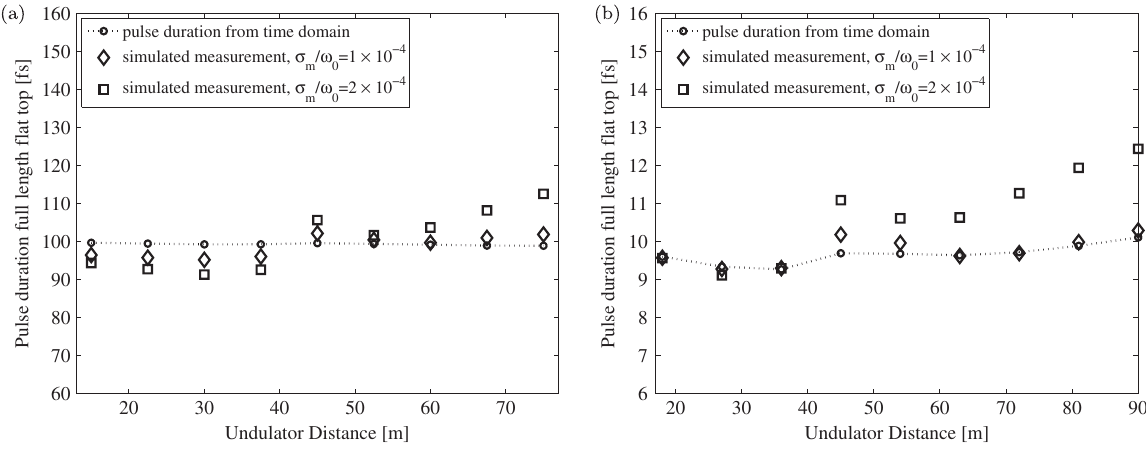
FIG. 3. Simulated measurement of x-ray pulse duration vs undulator distance. (diamonds) Relative spectrometer resolution =! 0 ¼ 10 (cid:1) 4 , (squares) relative spectrometer resolution (cid:2) (cid:2) m Electron bunch is flattop, 3 (cid:7) m